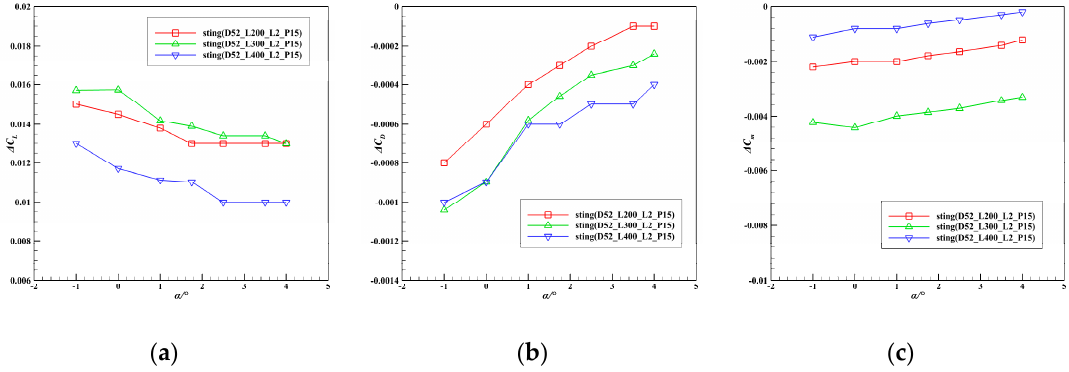
Figure 9. Support interference results of the BWB aircraft with di ff erent straight-section lengths (L = 200 mm / 300 mm / 400 mm, Ma = 0.75): ( a ) C L - α curves; ( b ) C D - α curves; ( c ) C m - α curves. Table 6. Interference results of the BWB aircraft with di ff erent straight-section lengths (L = 200 mm / 300 mm / 400 mm, Ma = 0.75, α = 0 ◦ ).